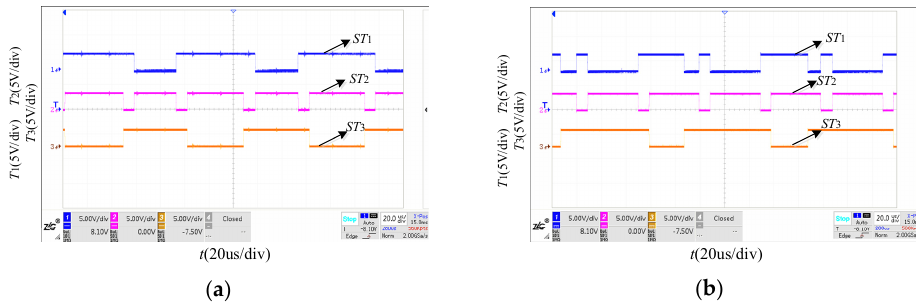
Figure 12. Control signal of ST 1 , ST 2 , ST 3 : ( a ) traditional modulation strategy; ( b ) improved modu- lation strategy.